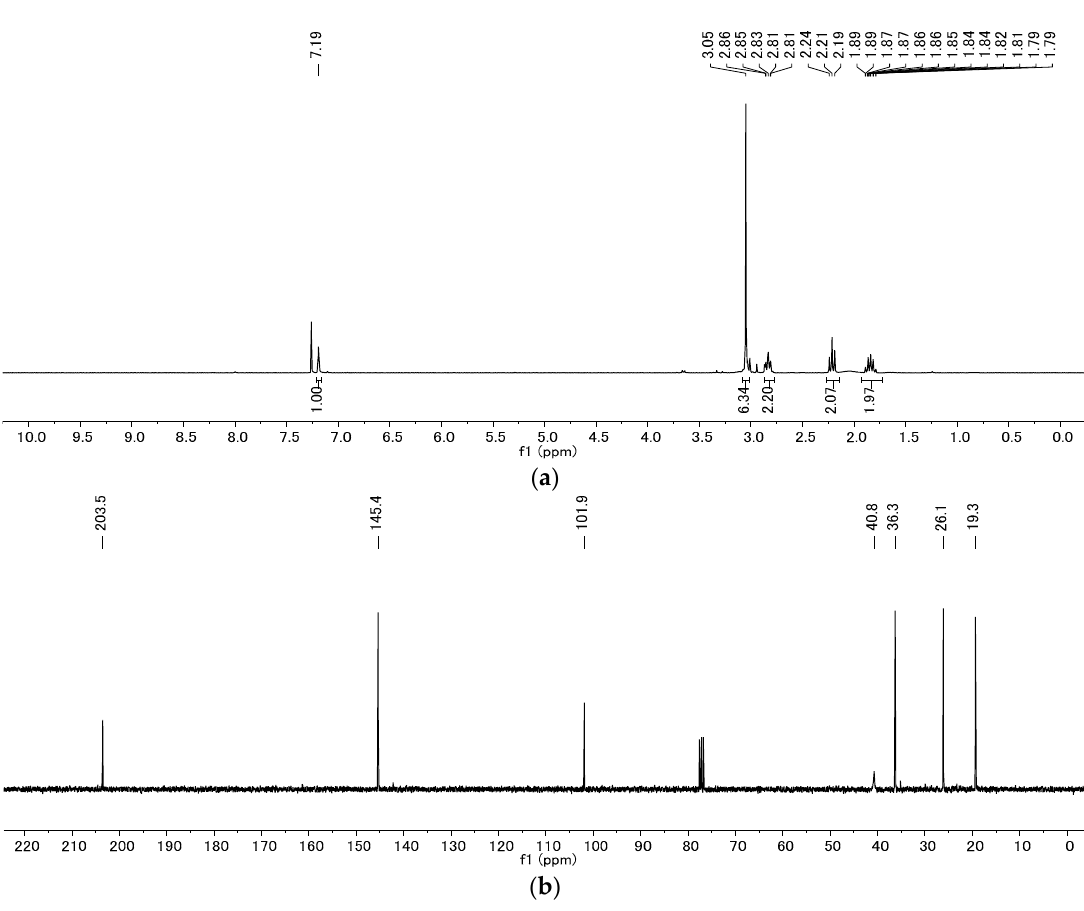
Figure 3. ( a ) 1 H NMR and ( b ) 13 C NMR spectra of 2-((dimethylamino)methylene)cyclopentanone ( 3 ).